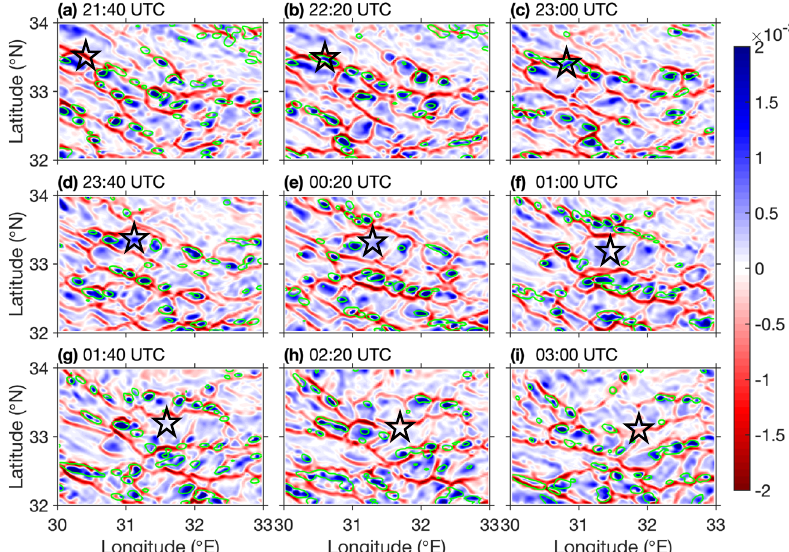
Fig. 4 Nine snapshots of surface wind divergence (color bar; unit: s − 1 ) with surface rain rate of 1 mm h − 1 (green contours). Obtained from COSMO simulations (between 25-26 January 2018, at 40-min intervals). The black stars mark the location of the tracked open cell, which is ( a ) located over a convergence boundary, corresponds to the middle cloud in Fig. 6a. b Affected by signi fi cant precipitation, corresponds to Fig. 6b. c – f Gradually turned into a divergence center, corresponds to Fig. 6c. g , h Affected by nearby rain events, corresponds to Fig. 6d. i Turned back into a convergence area, corresponds to Fig.